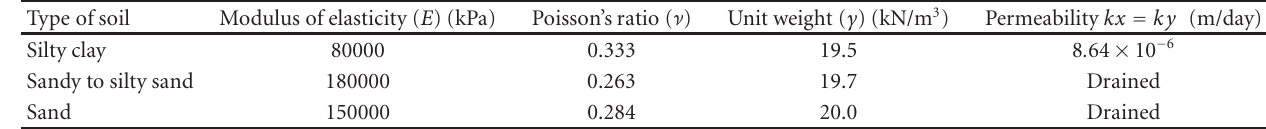
Table 1: The soil parameters of the analyzed section of the proposed Baghdad metro